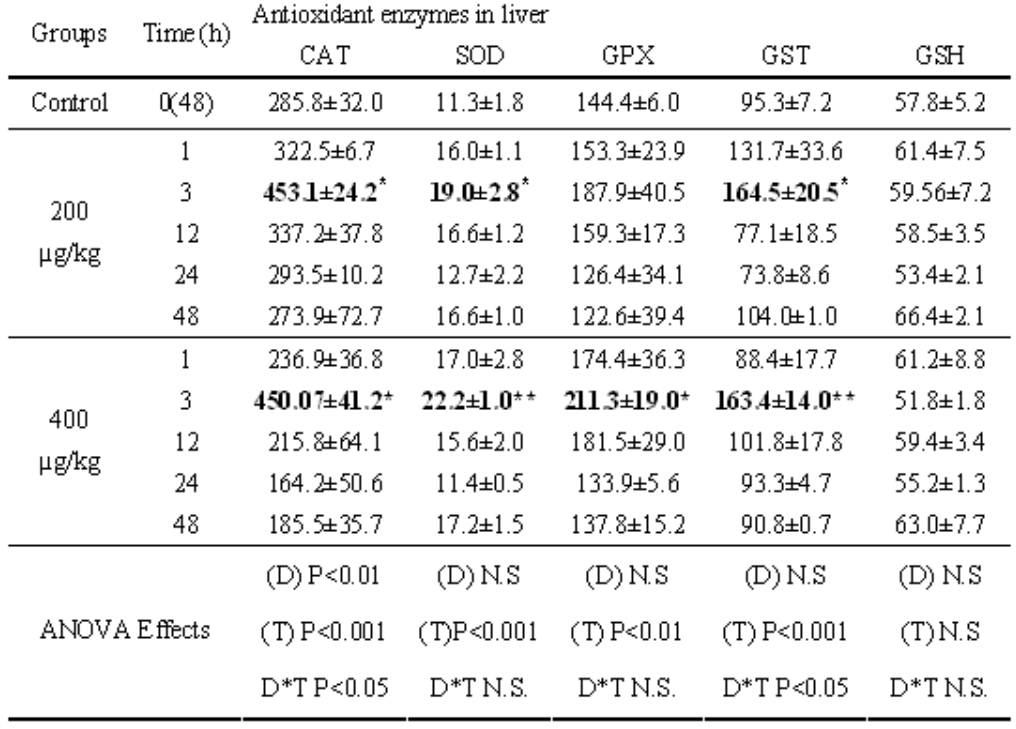
The Activities of Antioxidant Enzymes CAT, SOD, GPX, and GST and GSH Levels in